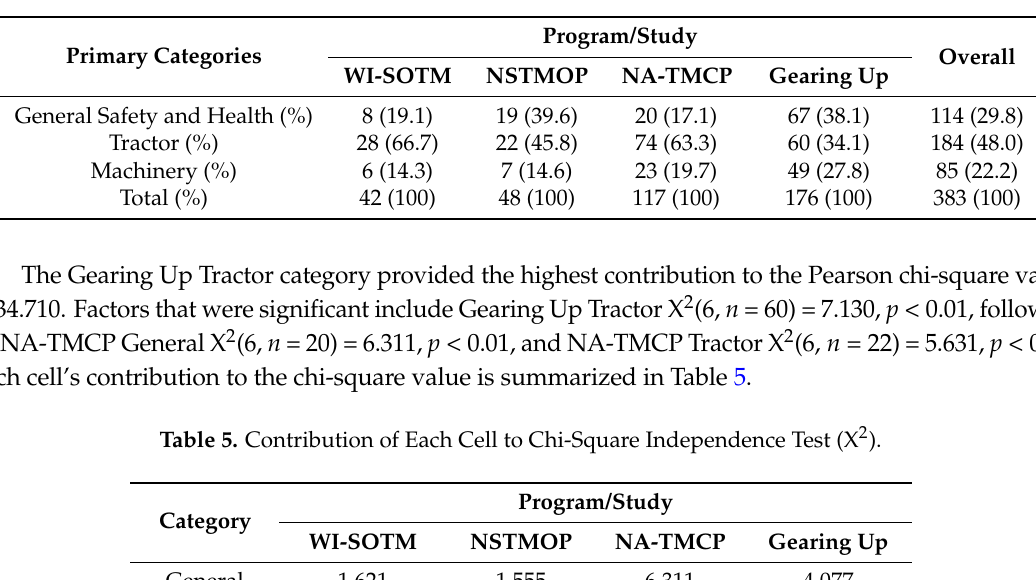
Table 4. Learning Outcome Count and Percentage within the Primary Categories. ( n = 383).